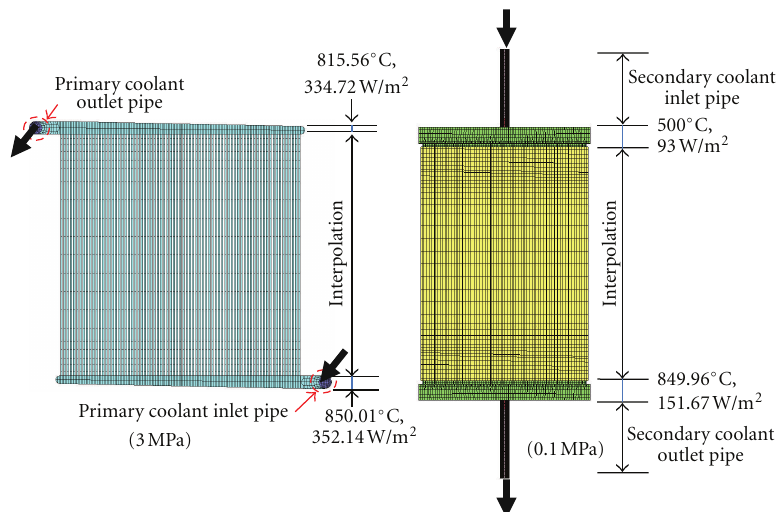
Figure 9: Boundary condition of primary/secondary coolant.